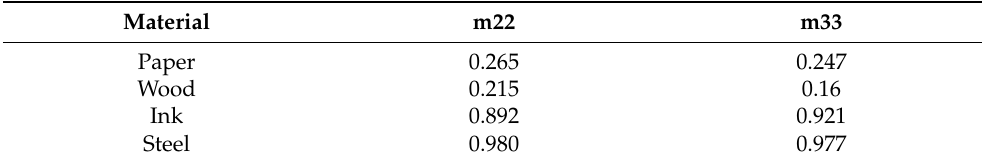
Table 2. Mueller matrix elements of different materials